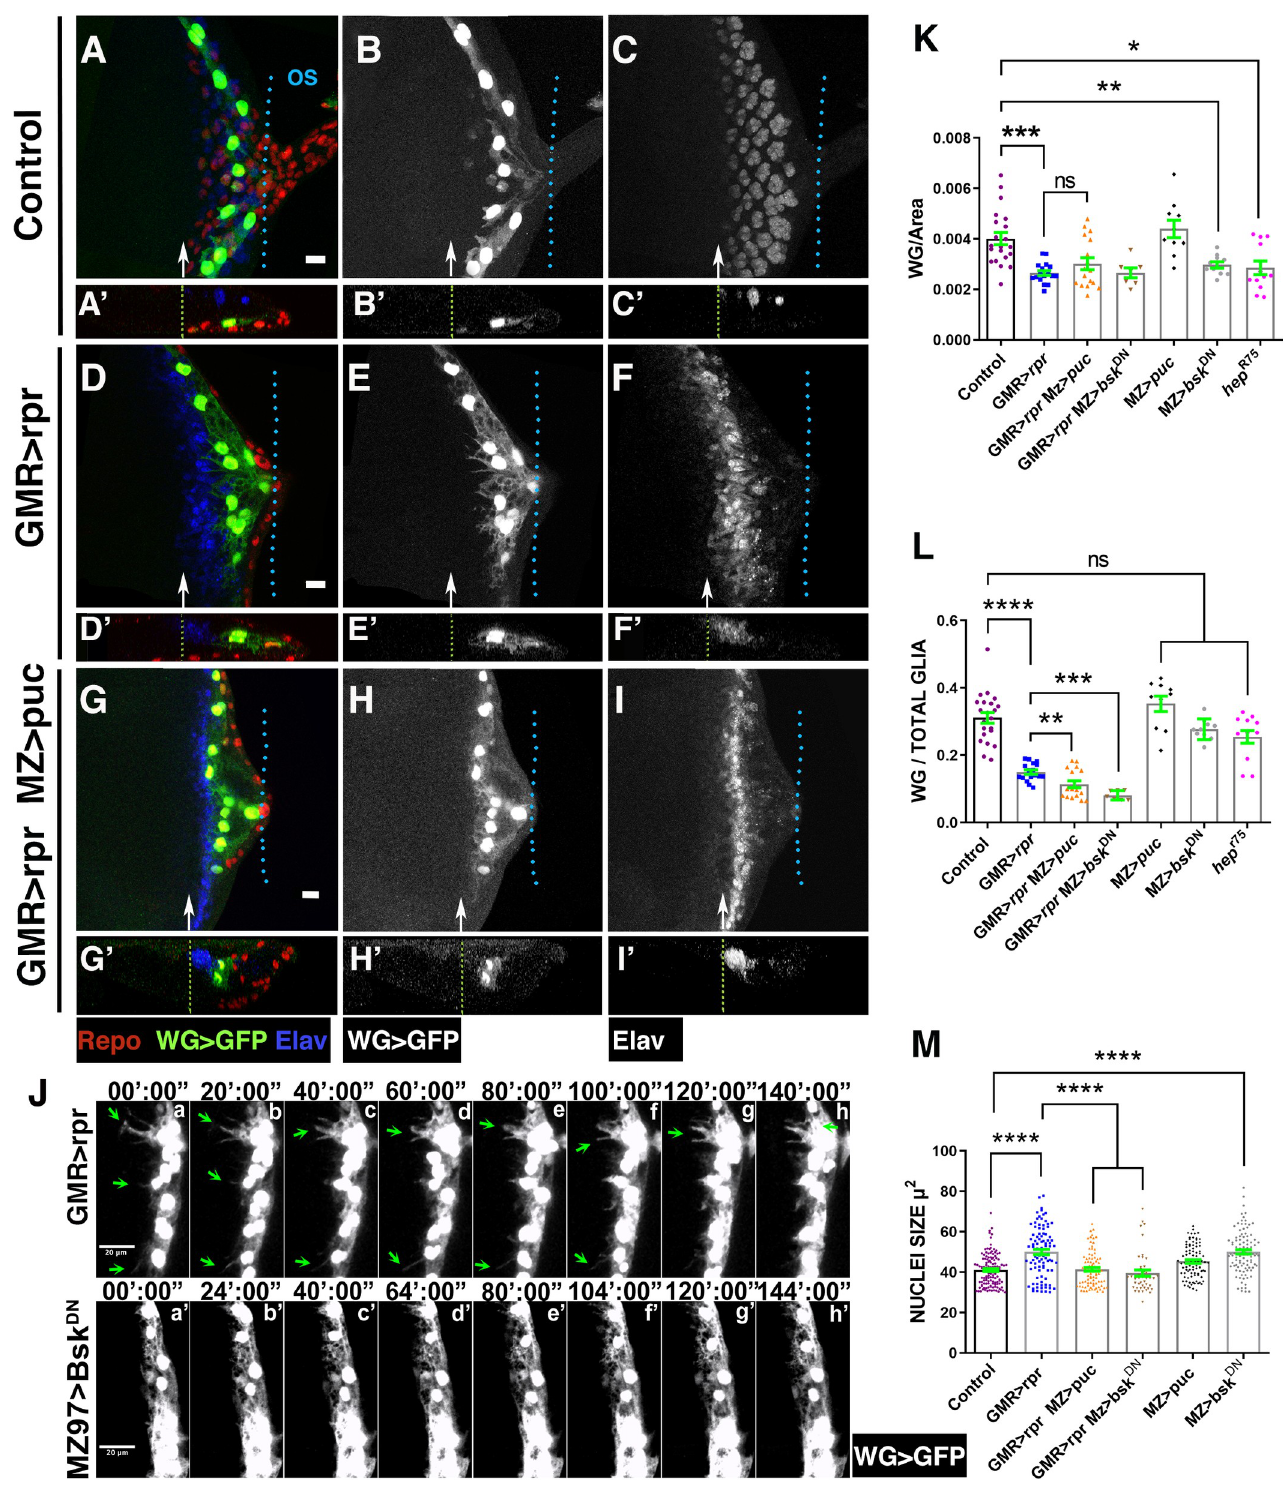
Fig 10. JNK depletion affects the morphology and behaviour of WG in damaged eye discs. (A–I’) Third instar eye discs stained with anti-Elav (blue A, A’, D, D’, G, and G’ and grey C, C’, F, F’, I, and I’) and anti-Repo (red). (A–I’) Mz97-Gal4 driving expression of UAS-GFP (green A, A’, D, D’, G, and G’ and grey B, B’, E, E’ H, and H’) reveals WG cells in control UAS-GFP Mz97-Gal4; QUAS-rpr (A–C’), damaged eye discs ( GMR-QF; UAS-GFP Mz97-Gal4; QUAS-rpr ( D–F’), and damaged eye discs with depleted JNK signalling function GMR-QF; UAS-GFP Mz97-Gal4; repo-Gal4 QUAS-rpr/UAS-puc (G–I’). (A’–C’, D’–F’, and G’–I’)